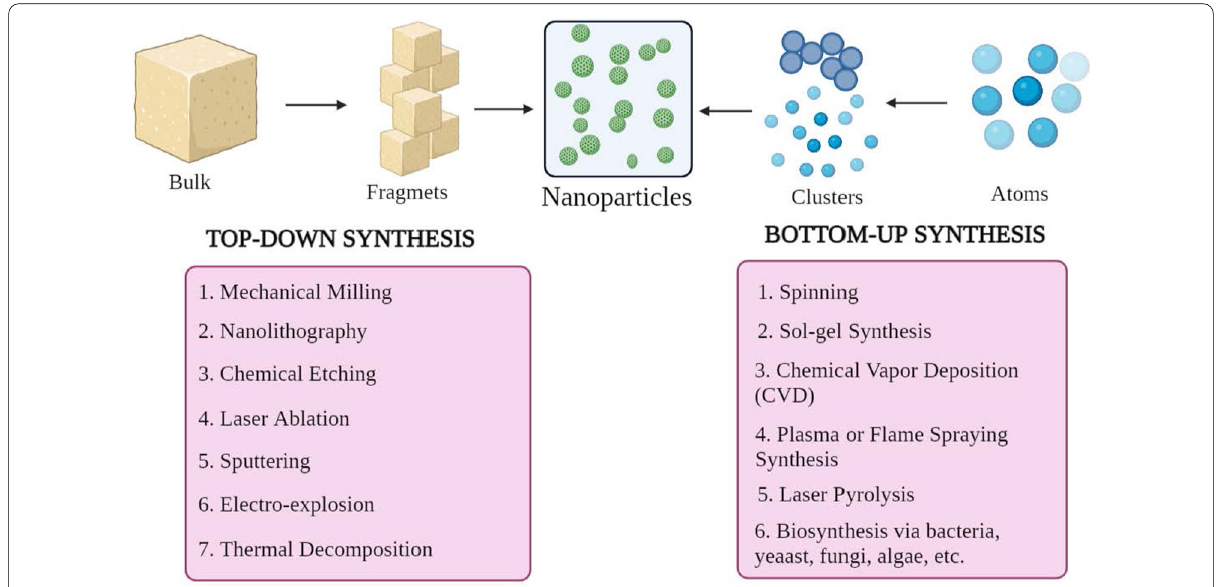
Fig. 2 Classification of NP synthesis a top-down and b bottom-up